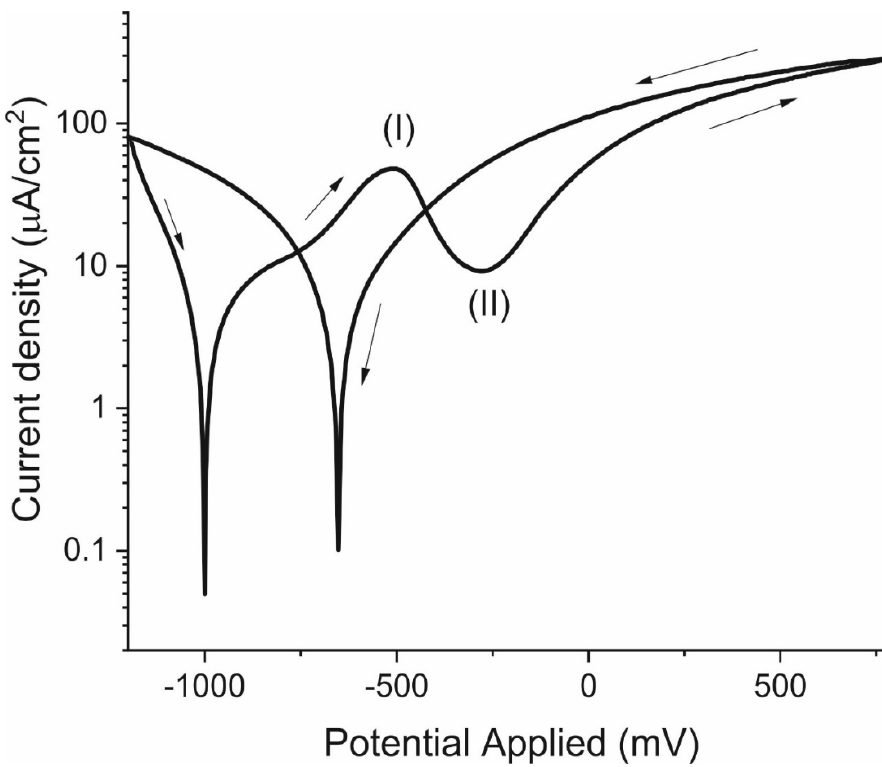
Figure 11. Passivation curve for specimen E21 after 232 days under anoxic conditions.